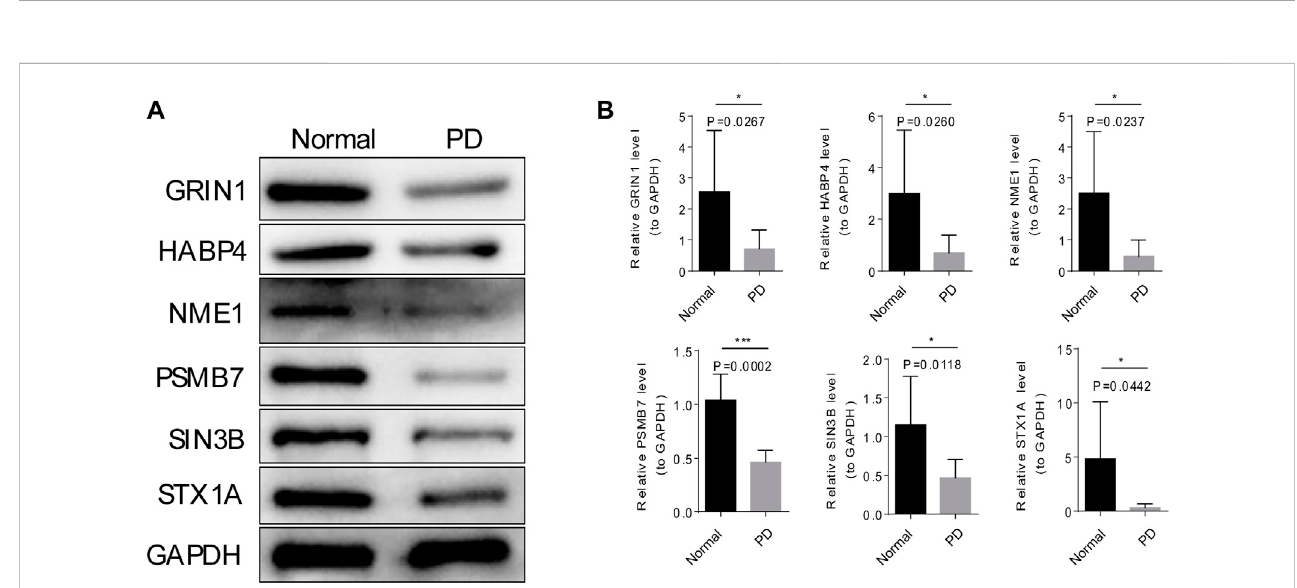
FIGURE 8 Veri fi cation of the protein expression of six modular genes by Western blot. (A) The grayscale values six of modular genes in PD and normal samples by Western blot. (B) The mages of six modular genes in PD and normal samples by Western blot.